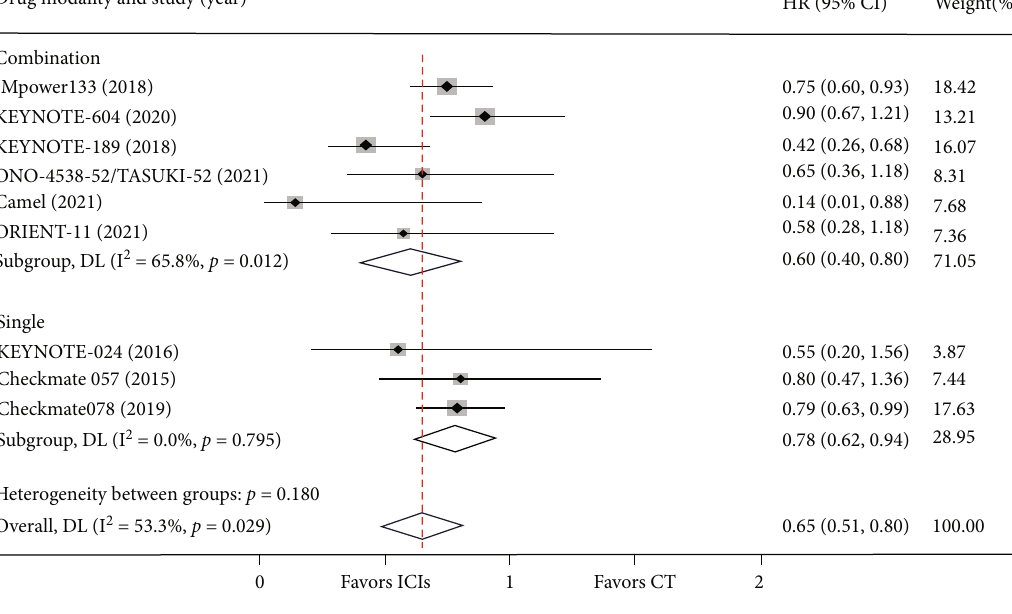
Figure 8: Subgroup analyses of PFS by drug modality between the immune checkpoint inhibitors (ICIs) group and the chemotherapy (CT) group for lung cancer with